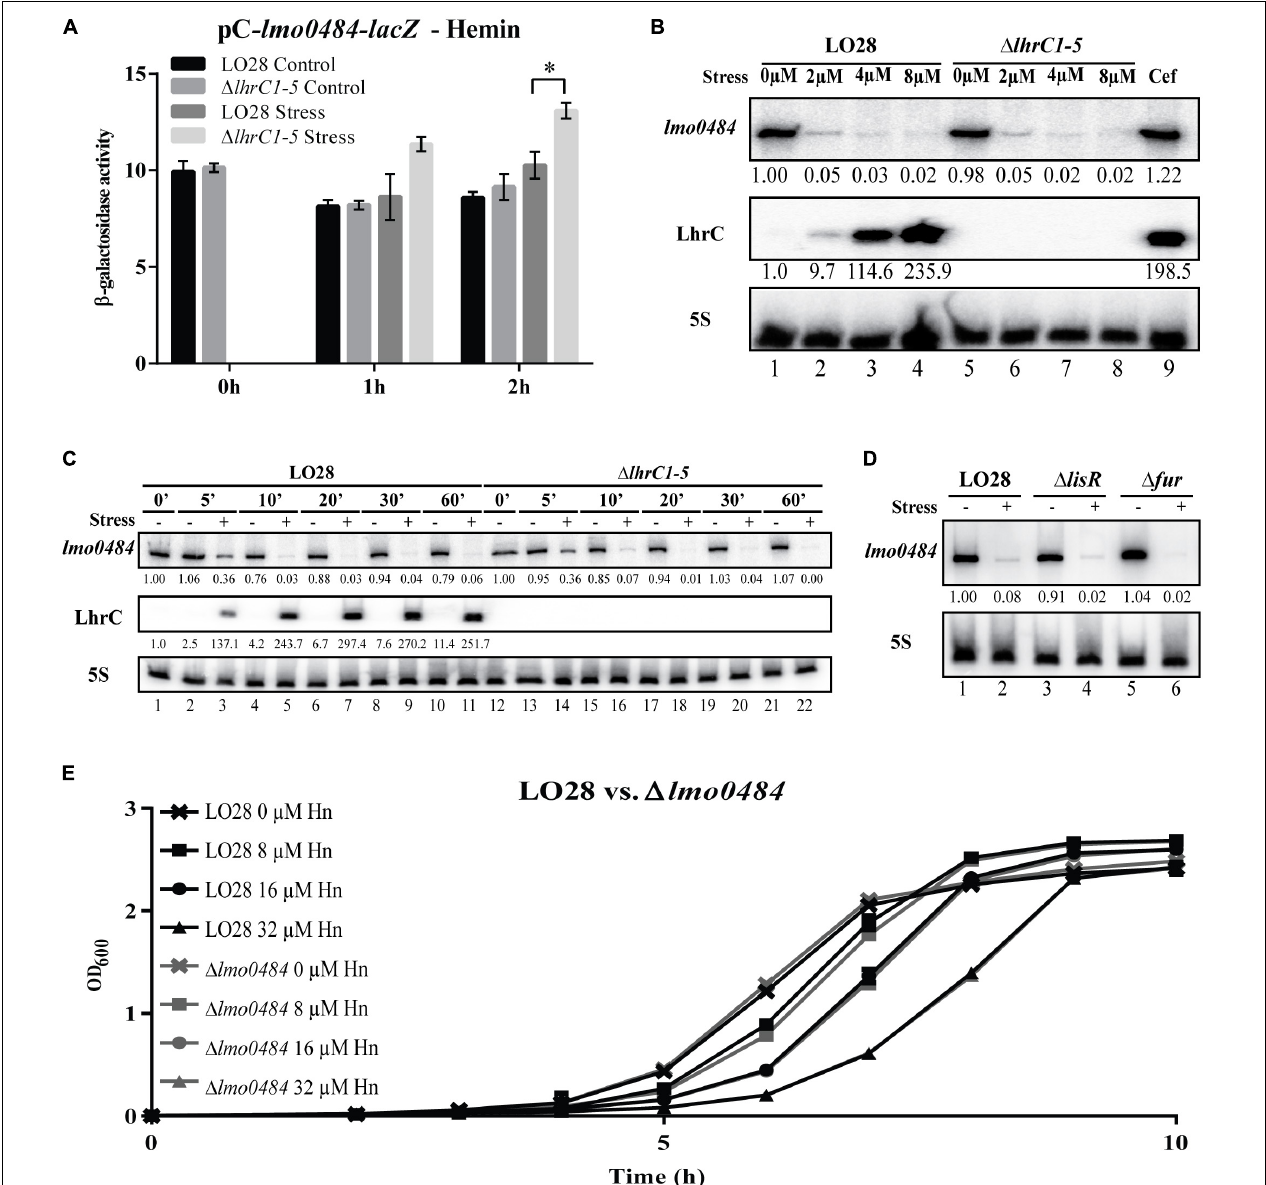
FIGURE 8 | Assessing the effect of LhrC1–5 on the novel target gene lmo0484 under hemin stress. (A) β -galactosidase assay of LO28 wild-type and (cid:49) lhrC1–5 strains carrying a translational reporter gene fusion of lmo0484 to lacZ in the vector pCK-lac. β -galactosidase activities of wild-type and mutant cells were measured at the indicated time points under non-stress conditions (Control) and after exposure to 8 µ M hemin (Stress). The results are the average of three biological replicates, each carried out in technical duplicates. After 2 h of stress, a significant difference between the mutant and wild-type cells was observed ( p < 0.005). (B) Northern blot analysis of lmo0484 mRNA after exposure to various concentrations of hemin. Samples were taken from LO28 wild-type and (cid:49) lhrC1–5 cultures exposed to 1 h of 0, 2, 4, or 8 µ M hemin stress. A sample from LO28 wild-type culture exposed to 9 µ M cefuroxime was used as a control. Northern blots were probed for lmo0484 mRNA, LhrC1–5 and 5S rRNA (loading control). Relative levels of lmo0484 mRNA and LhrC1–5 (normalized to 5S) are shown below each lane. (C) LhrC induction profile and time-dependent regulation of lmo0484 mRNA in response to hemin stress. At time = 0, corresponding to OD 600 = 0.35, LO28 wild-type and (cid:49) lhrC1–5 cells were split in two, and one half of the culture was treated with 8 µ M hemin (+), whereas the other half was left untreated (–). Samples were harvested at several time points (0, 5, 10, 20, 30, and 60 min relative to the addition of hemin) and total RNA was prepared for northern blot analysis. The blot was probed for lmo0484 mRNA, LhrC1–5 and 5S rRNA (loading control). Relative levels of lmo0484 mRNA and LhrC1–5 were normalized to 5S and are shown below each lane. (D) Testing the role of LisR and Fur in the heme-dependent repression of lmo0484 . Samples were taken from LO28 wild-type, (cid:49) lisR and (cid:49) fur cultures exposed for 1 h to 8 µ M hemin stress (+) as well as from non-stressed cultures (–). Northern blots were probed for lmo0484 mRNA and 5S rRNA (loading control). Relative levels of lmo0484 mRNA normalized to 5S are shown below each lane. (E) Stress tolerance assay of the (cid:49) lmo0484 strain compared to LO28 wild-type. Wild-type and (cid:49) lmo0484 strains were grown in BHI containing 0, 8, 16, or 32 µ M hemin. Bacterial growth was monitored until all cultures reached stationary phase. The average of three biological replicates is shown.